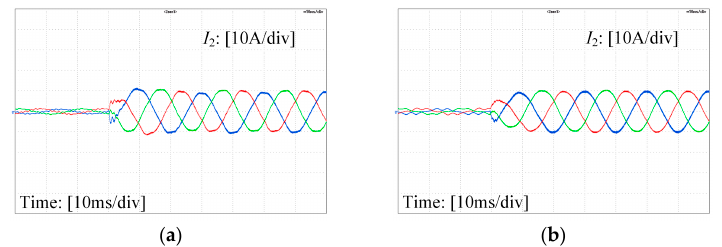
Figure 18 . Grid-connected converter starting in rectifier mode with DFPS-CVFF. ( a ) SCR = 10; ( b ) SCR = 2.